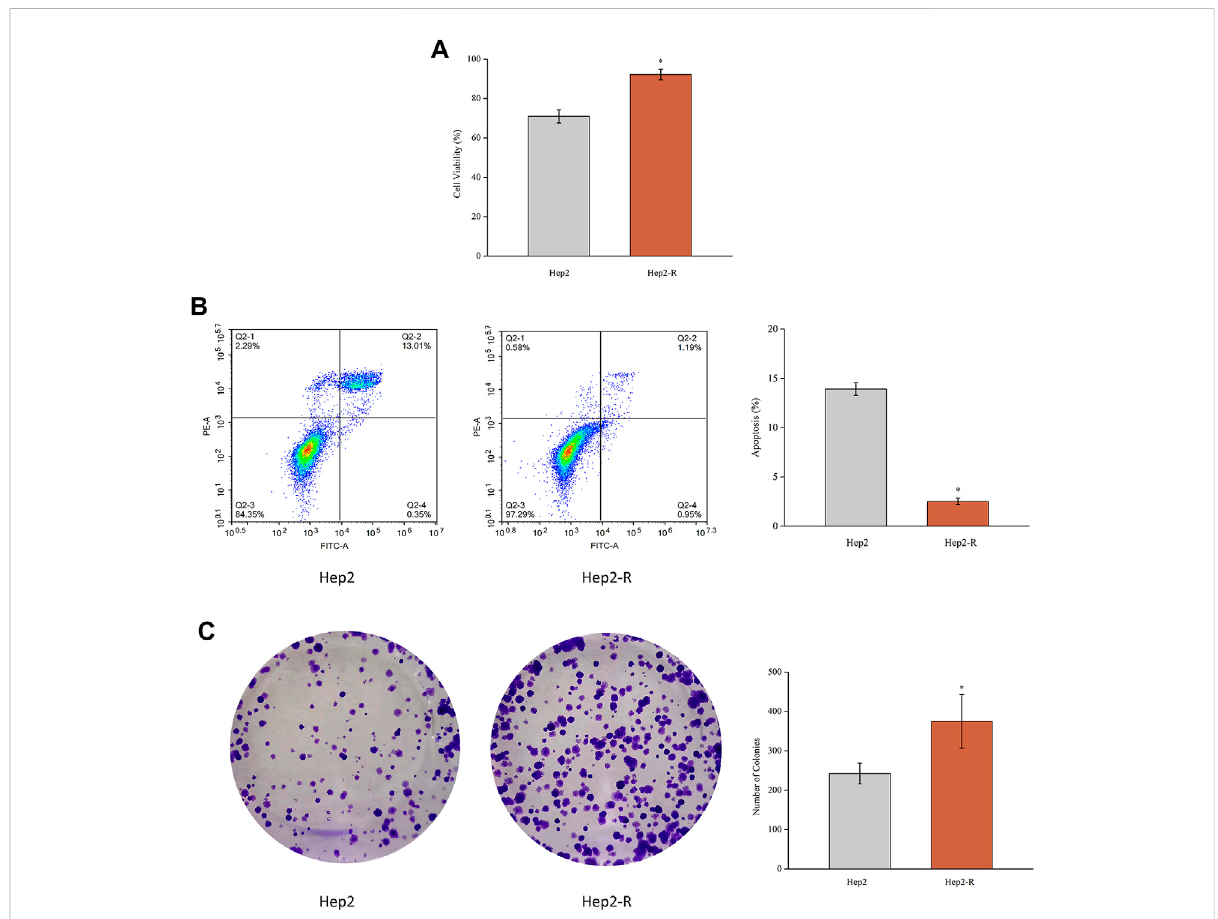
with irradiation, Figure 3B), Subset 3 (three radiosensitive tumors versus three radioresistant tumors 5 h after irradiation, Figure 3C), Subset 4 (three radiosensitive tumors versus three radioresistant tumors 24 h after irradiation, Figure 3D). The Venn diagram revealed that a total of 13 DEGs were found when our data (Hep2 versus Hep2-R) and GSE9714 compared with above four subsets. Six genes were overexpressed and seven genes were lowly expressed in radioresistant cells and tissues in comparison with the normal with absolute average fold change > 1 and p < 0.05 (Figure